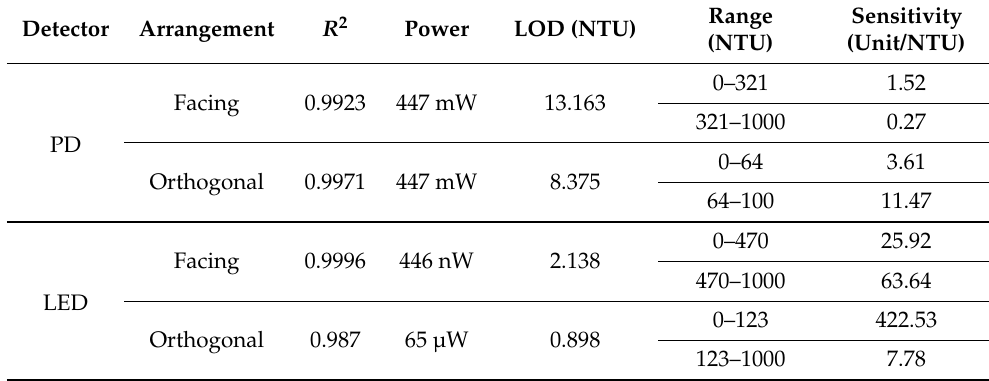
Table 3. List of calculated sensitivities, ranges, and limits of detection for the four data